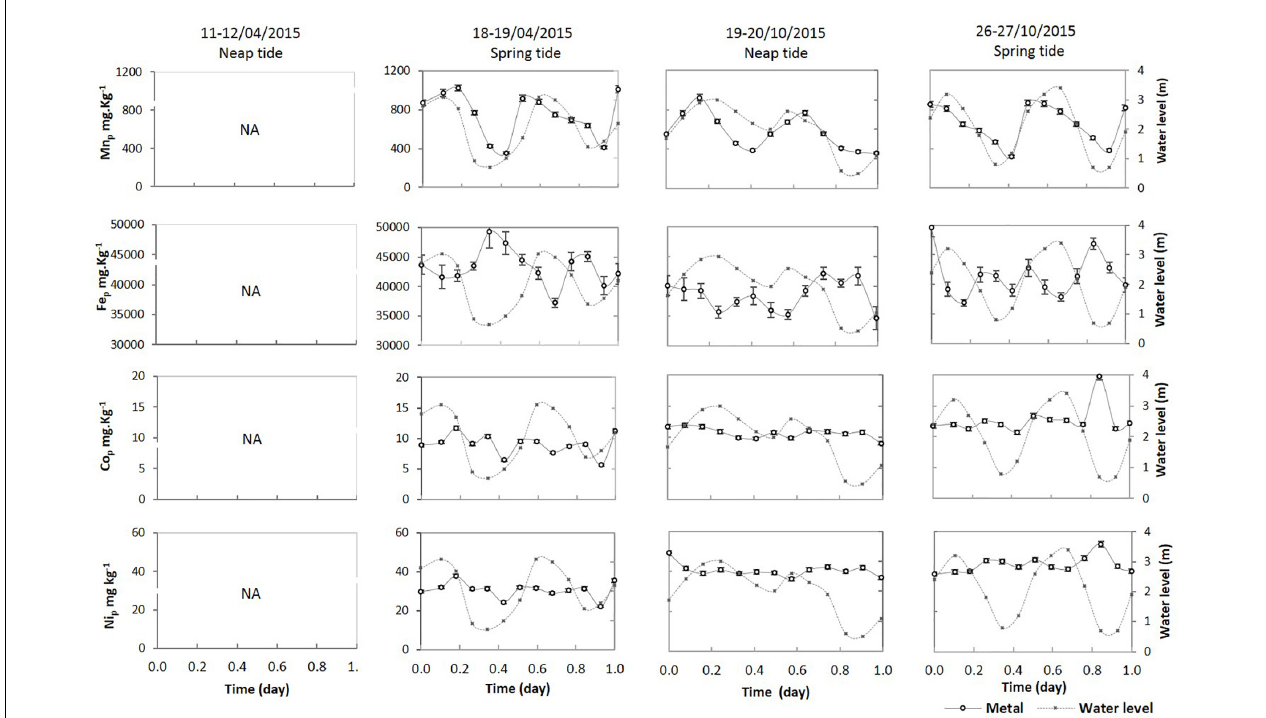
FIGURE 4 | Distributions of the particulate metal concentrations (M P ) during neap and spring tidal cycles during the dry season (04/2015) and the wet season (10/2015). NA: not